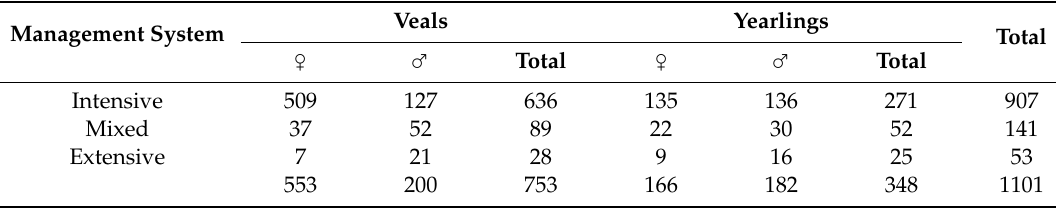
Table 1. Number and distribution of animals studied based on the management system, age group and